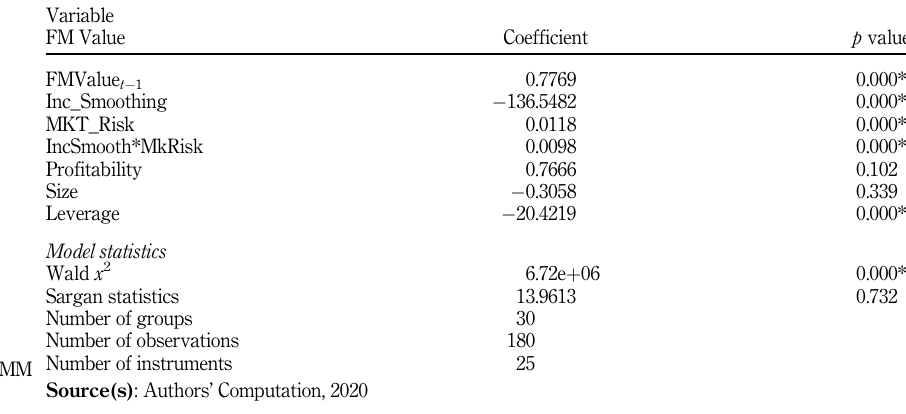
Table 2. Two-stepsystemGMM estimation